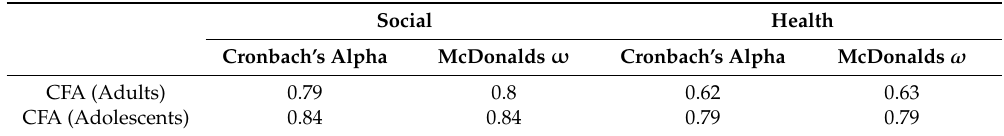
Table 3. Measures of internal